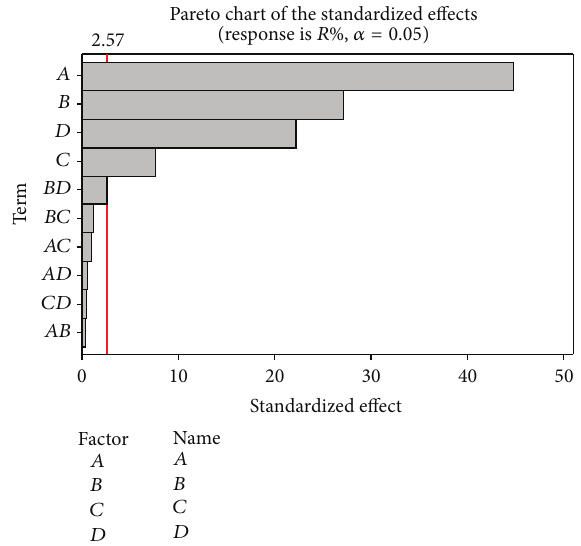
Figure 4: Pareto chart of standardized effects on removal efficiency.